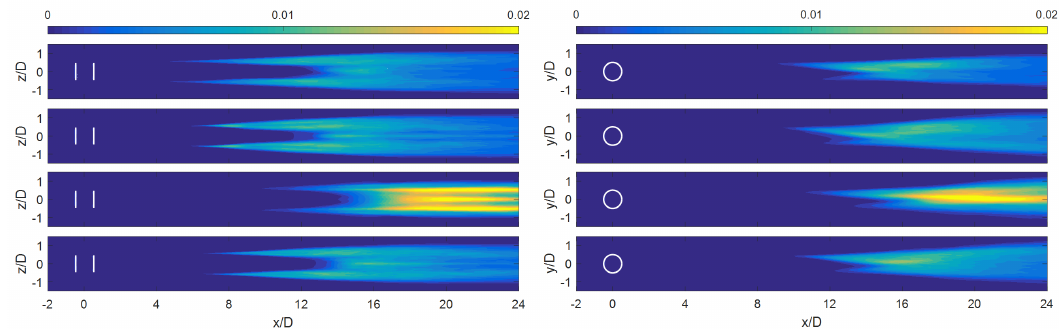
) in the central vertical x − z 0